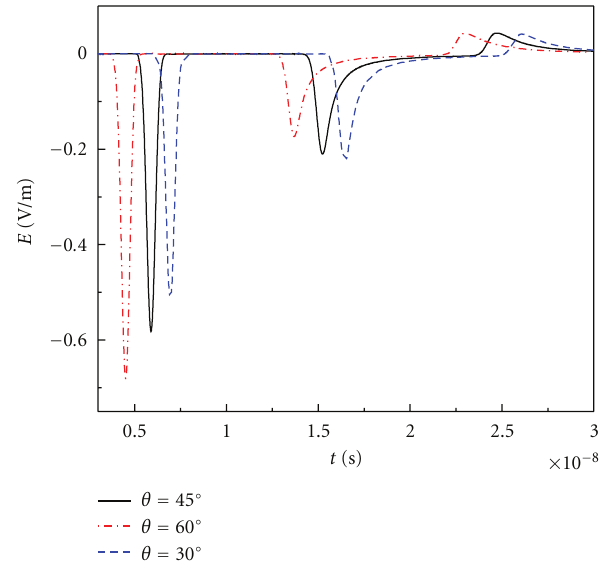
Figure 8: The reflected wave on the height of thin wire located above the half-space with di ff erent incident angle.